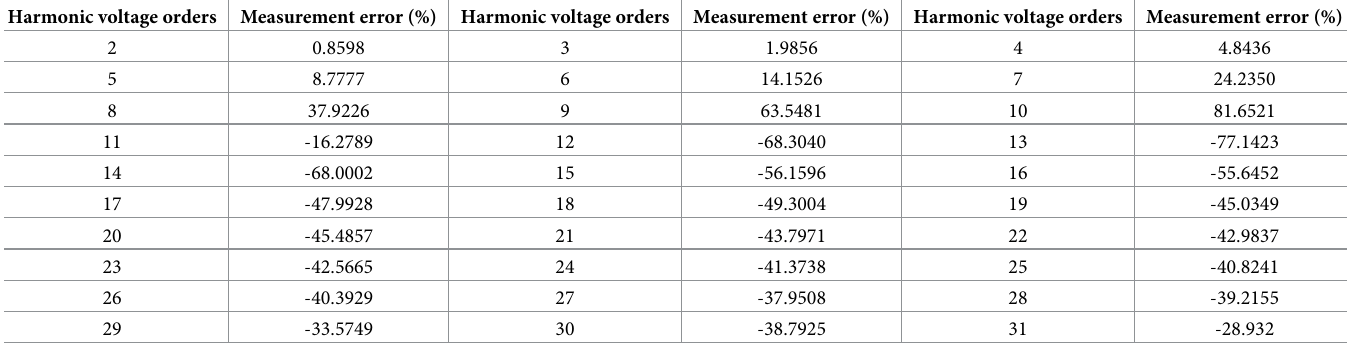
Table 10. Harmonic measurement error of the 35-kV